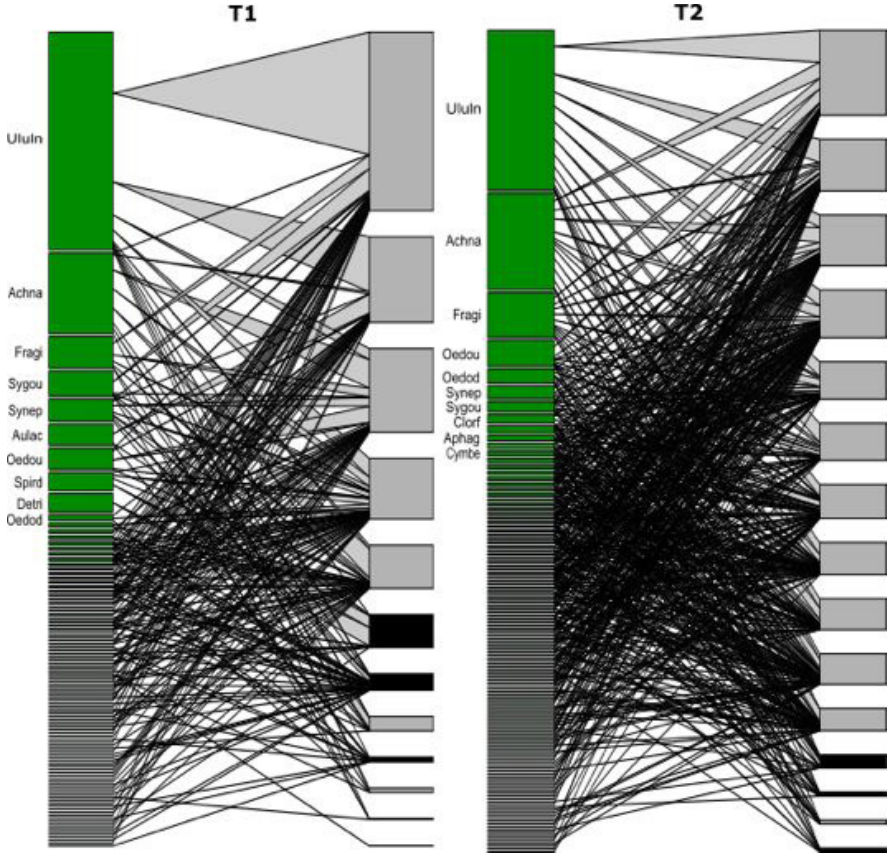
Figure 9. Interaction networks based on the resource categories (periphytic algae from the food content and other food items) (left on the graphs- green) of Moenkhausia sanctaefilomenae (right on the graphs- gray) in treatments T1 (without zooplankton) and T2 (with zooplankton). Gray lines represent the species interactions, and the thickness of the line indicates the interaction frequency (in these networks, the abundance of the food items in the stomach contents of M. sanctaefilomenae ). The size of the bars represents the species or individual degree (number of species interactions). Black bars depict M. sanctaefilomenae individuals that had spent less than 4 days in the experiment. Food items labels: Ululn - Ulnaria ulna ; Achna - Achnanthidium minutissimum ; Fragi - Fragilaria sp.1; Sygou - Synedra goulardii ; Synep - Synedra sp.1; Aulac - Aulacoseira sp.1; Oedou - Oedogonium sp.1; Spird - Spirogyra sp.2; Detri- Debris; Oedod - Oedogonium sp.2; Clorf - Chlorophyceae sp.1; Aphag - Aphanocapsa sp.1; Cymbe - Cymbella